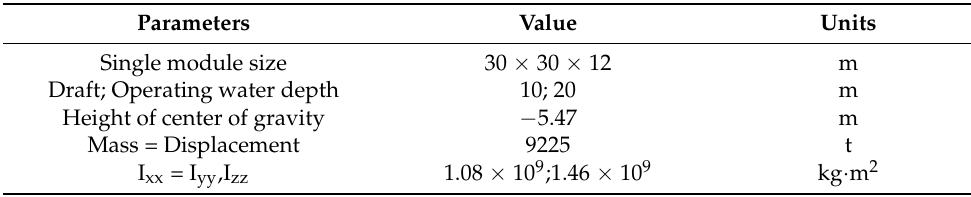
Table 1. Main structure design parameters for the MIFS. Parameters Value Units Single module size 30 × 30 × 12 m Draft; Operating water depth 10; 20 m Height of center of gravity − 5.47 m Mass = Displacement 9225 t I xx = I yy ,I